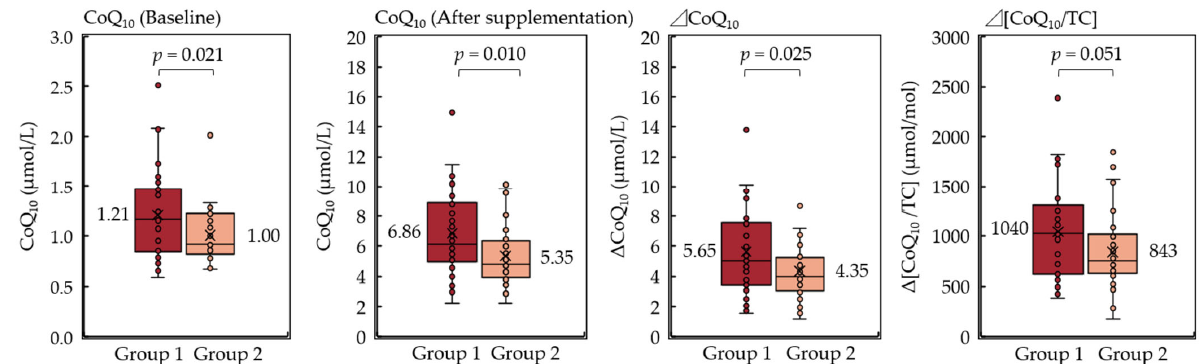
Figure 4. Box plots showing the serum CoQ 10 levels at baseline and after 1 year of supplementation, Δ CoQ 10 , and